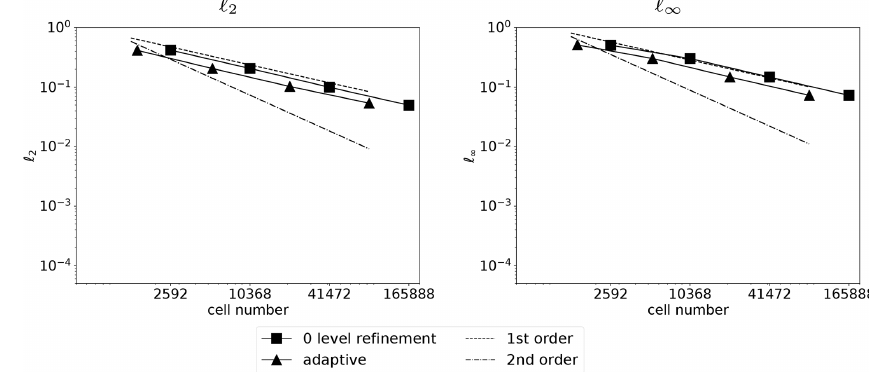
Figure 15. Convergence rate of the numerical results with respect to the number of cells in the divergent test case using the same initial spatial resolution with multiple refinement levels.